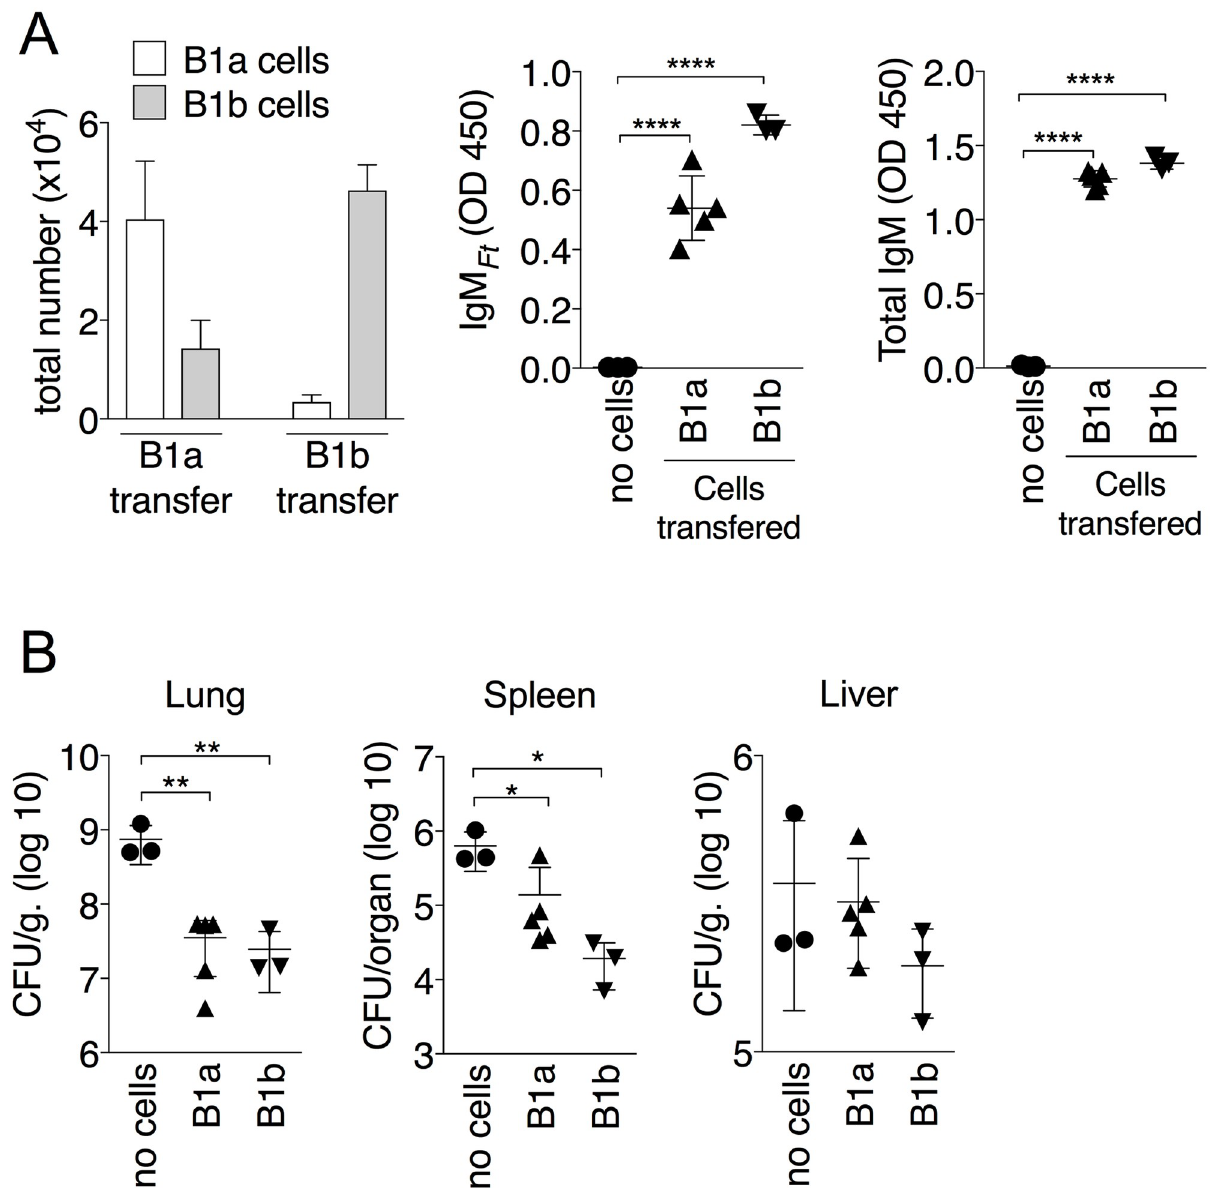
Fig 2. Both B1a and B1b cells produce IgM . Rag1 -/- mice reconstituted with purified B1a or B1b cells were immunized i.p. with LPS Ft number of peritoneal B1a or B1b cells in reconstituted Rag1 -/- mice. Level of IgM Ft and total IgM in serum was measured on day 7 p.i. (B) Reconstituted Rag1 -/- mice were then infected with Ft (4x10 3 cfu) and euthanized seven days later for measurement of bacteria burdens in organs. One representative experiment of two is shown. Data are expressed as mean ± SD. One-way ANOVA Tukey Post-test. � p < 0.05, �� p < 0.01, ���� p < 0.0001. See also S2 Fig.